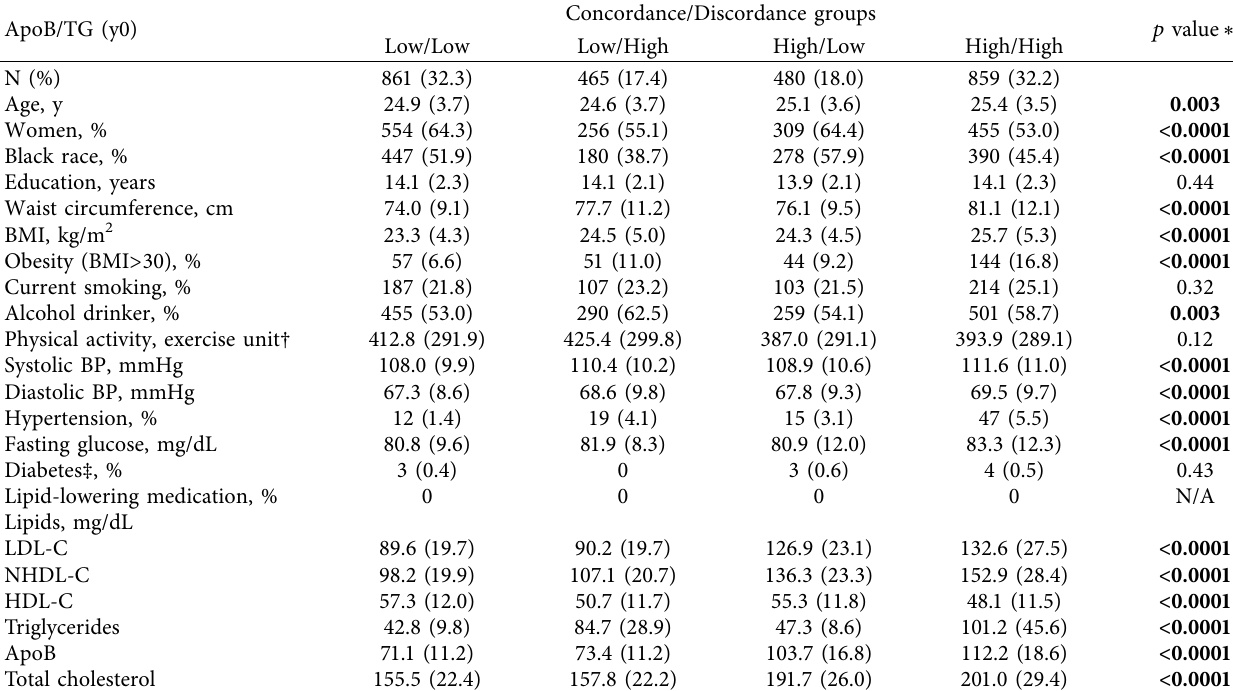
Table 2: Baseline characteristics of NAFLD-eligible participants by concordance/discordance groups based on medians of ApoB/TG levels [the CARDIA study